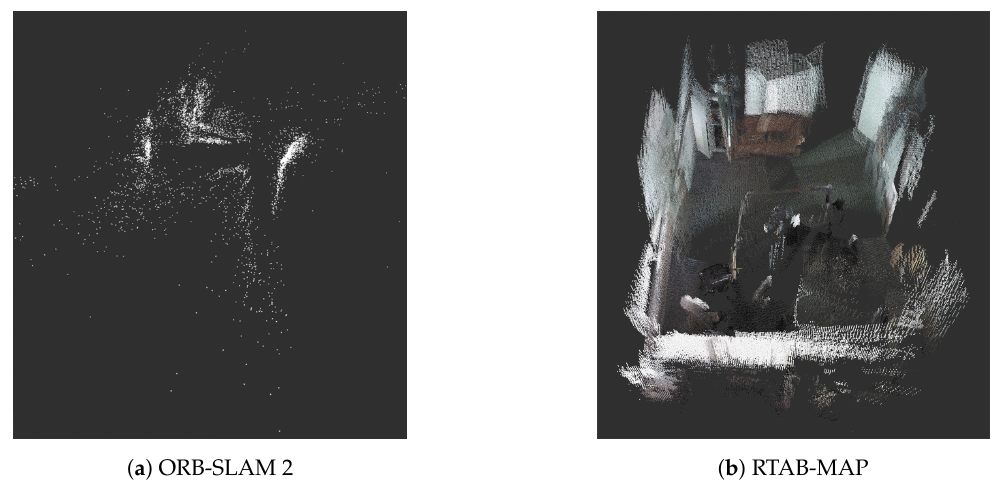
Figure 4. Resulting map for 3D SLAM algorithms using Orbbec Astra Pro camera data from a pre-recorded dataset [63] and the default parameter values (see Table 1 for the camera specifica- tions). The camera was mounted on a Turtlebot 2 at 65 cm of height. The two figures have the same